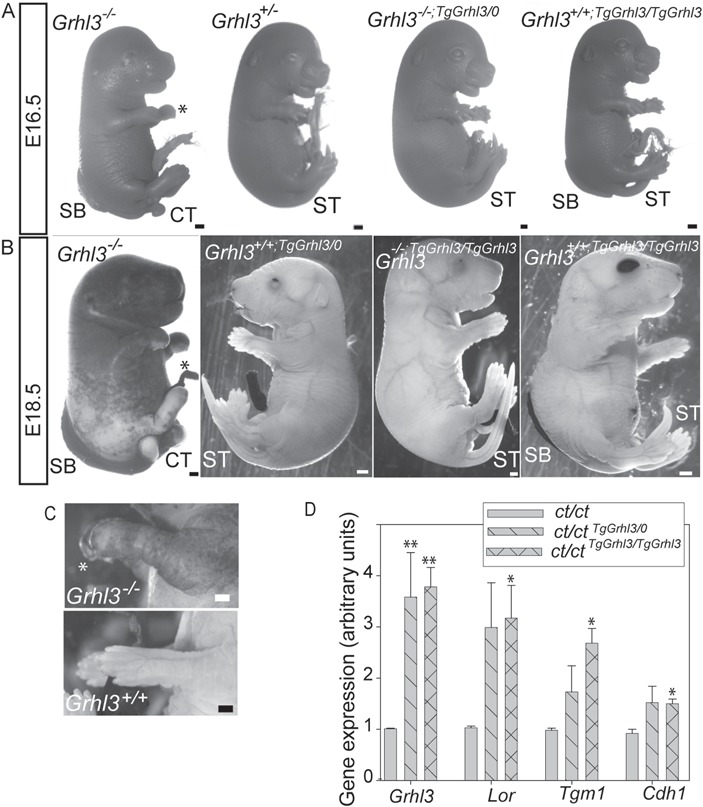
Establishment of the epidermal barrier is not compromised by Grhl3 overexpression. (A–C) Integrity of the permeability barrier was determined by dye penetration assay. At E16.5 (A), all genotypes show dye penetration, whereas at E18.5 (B) Grhl3-/- is the only genotype with incomplete epidermal barrier. Note that barrier formation is rescued by transgenic expression of Grhl3 in Grhl3-/-;TgGrhl3/TgGrhl3 fetuses (in parallel with rescue of NTDs). Although Grhl3 overexpression causes SB, the epidermal barrier is established by E18.5 in hemizygous and homozygous transgenics. Note that limbs appear normal in transgenic fetuses, unlike in Grhl3-/- (*, abnormal forelimbs in B,C). Moreover, partially or completely open eyelids are visible in the transgenic fetuses (B). Scale bar represents 1 mm; CT: curly tail; ST: straight tail. (D) Analysis of gene expression in E18.5 skin samples in litters from compound mutant/transgenic or Grhl3ct/ct;TgGrhl3/0 intercrosses shows that Grhl3 overexpression is associated with increased expression of Lor, Tgm1 and Cdh1 (significant differences from Grhl3ct/ct: *P < 0.05, **P < 0.001; ANOVA).